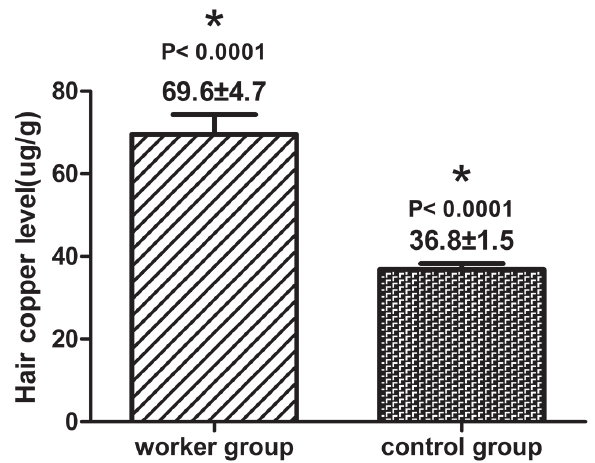
FIGURE 2 - Cu concentrations in hair of workers from different oil distribution product companies. Values were expressed as mean±SD, * represents a significant difference with P>0.01.